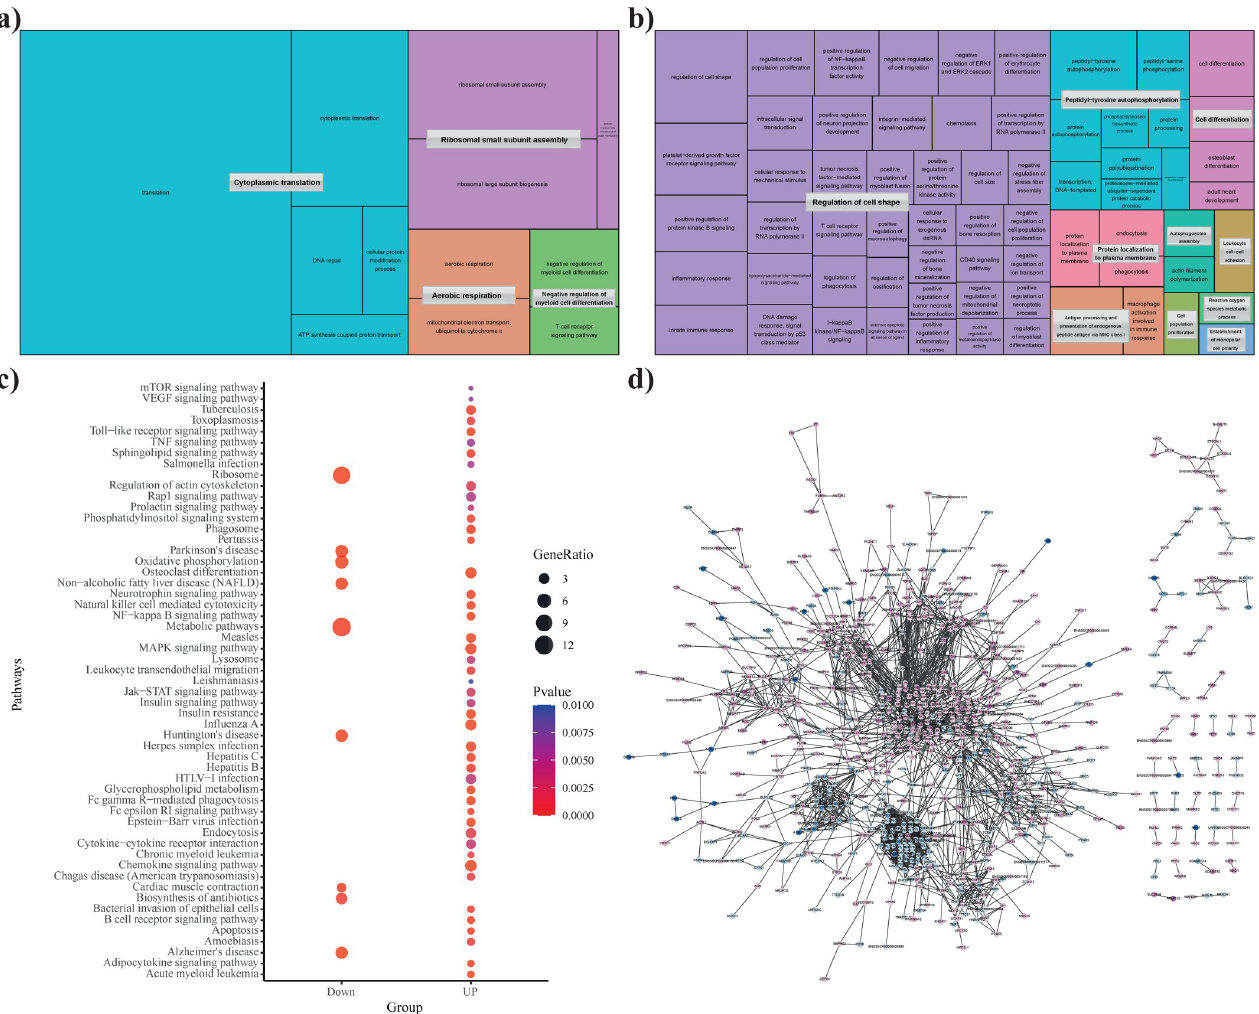
Fig 2. (a and b) Gene ontology study was done to identify the contribution and significance of differentially expressed upregulated and downregulated genes in minipig with p � 0.05. (c) KEGG pathway enrichment analysis after functional annotation with p < 0.01. Enriched pathway in L-type minipig was performed by dot-plot analysis. (d) protein-protein interaction analysis was done to visualize the upregulated and downregulated genes. Here, Blue nodes represent the downregulated genes and purple nodes represent the upregulation of genes.